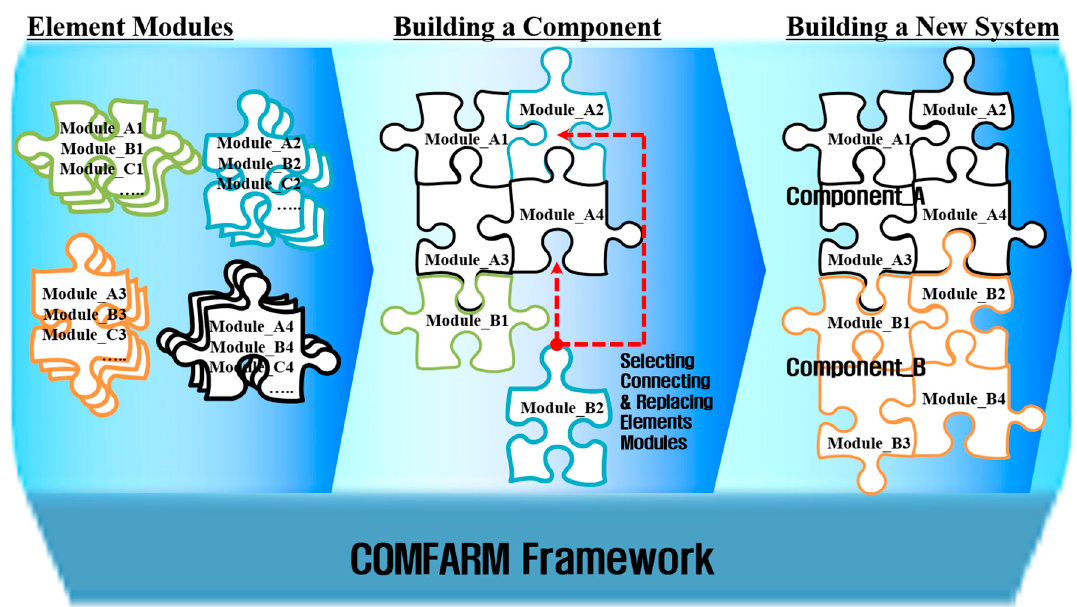
Figure 1. Basic concept for COMFARM (various modeling systems for any particular discipline can be constructed by connecting linkable components with element modules in COMFARM).